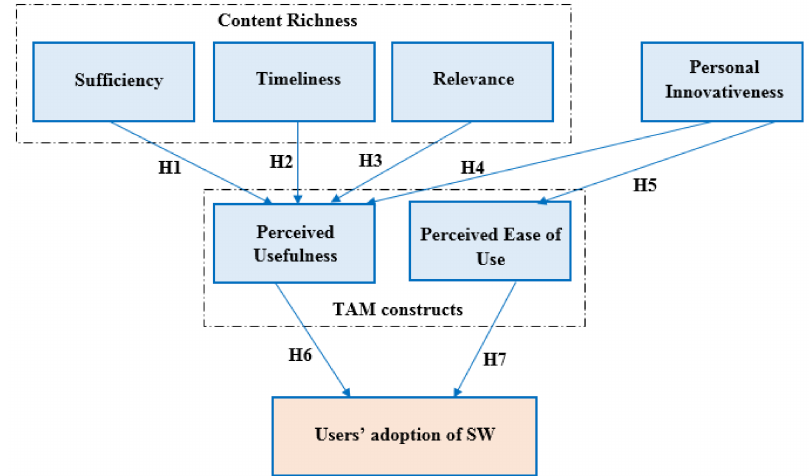
Figure 1. Research